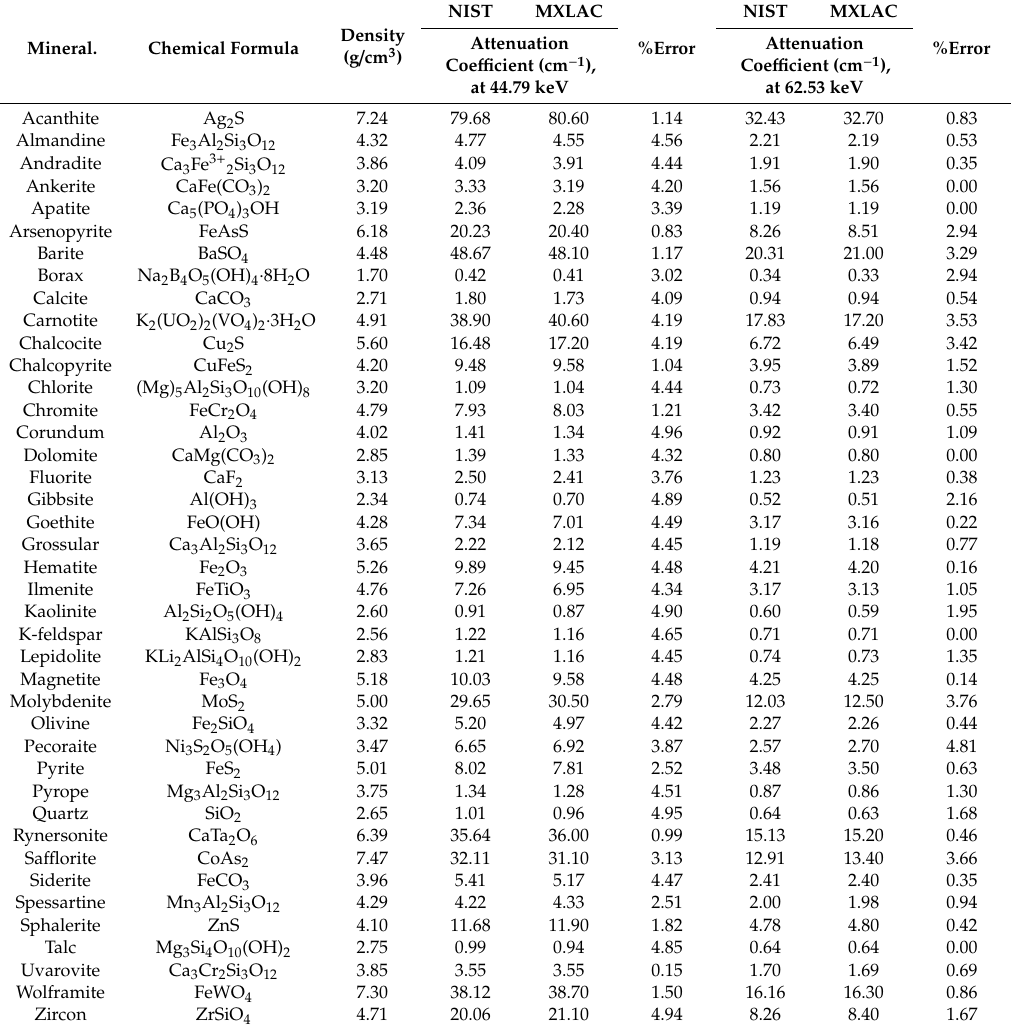
Table 2. Comparison of the NIST and MXLAC attenuation coe ffi cients for di ff erent types of minerals.